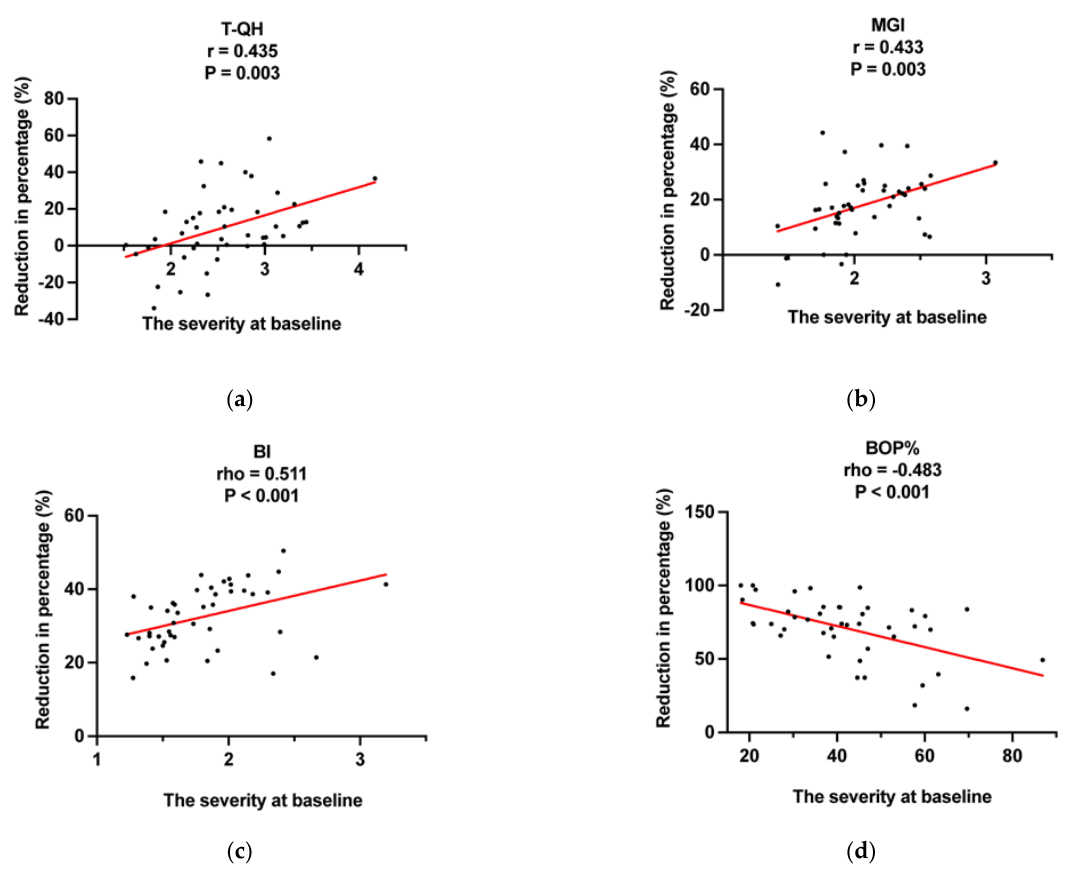
Figure 2. The correlation between the reduction in percentage at the baseline–12 weeks period and the severity at baseline (full analysis set). ( a ) T-QH, Turesky-Modified Quigley-Hein Plaque Index; ( b ) MGI, Modified Gingival Index; ( c ) BI, Bleeding Index; ( d ) BOP%, percentage of sites with bleeding on probing. Pearson correlation analysis was adopted in ( a , b ). Spearman correlation analysis was adopted in ( c , d ). r, Pearson correlation coefficient; rho, Spearman correlation coefficient. Furthermore, the comparison between the baseline–12 weeks period and adjacent visit points (baseline–4 weeks, 4 weeks–8 weeks, and 8 weeks–12 weeks periods) in FAS are present in Figure 3. During the baseline–12 weeks period, all gingival inflammation- related indices significantly decreased in both groups ( p < 0.001 for all, except BOP% in the control group, p = 0.004, FAS); the T-QH in the test group significantly decreased ( p < 0.001, FAS), while in the control group there were insignificant changes ( p = 1.000, FAS). T-QH, MGI, and BI in both groups and BOP% in the test group decreased significantly during the baseline–4 weeks period ( p < 0.001 for all, FAS). During the 4 weeks–8 weeks period, the MGI, BI, and BOP% decreased significantly in the test group ( p < 0.001, p < 0.001, and p = 0.008, respectively, FAS), while no significant difference was found in the control group ( p = 0.321, p = 0.244, and p = 1.000, respectively, FAS). The T-QH scores in the control group increased significantly for the 8 weeks–12 weeks period ( p = 0.004, FAS) and tended to increase in the test group, but the difference was not statistically significant ( p = 0.395, FAS). Similar results are found in PPS (Figure S4).